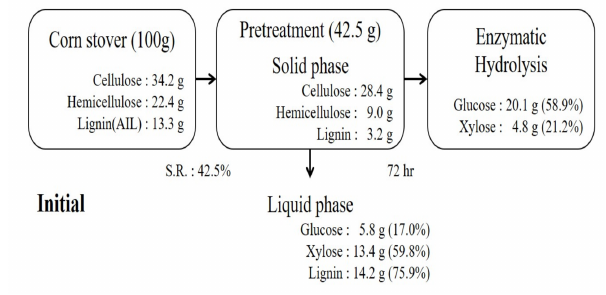
Figure 1. Mass balance of corn stover by predicted optimum pretreatment conditions.